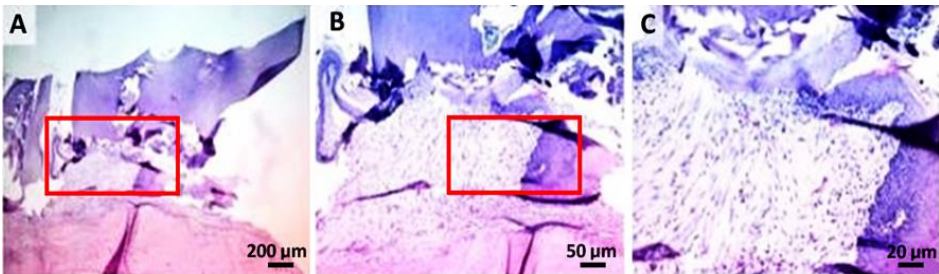
Figure 8. GO group: ( A , B ) hyperplasia and marked hyperkeratosis of the gingival epithelium, and partial replacement of the dental ligament with partially oriented fibro-vascularized connective tissue; ( C ) high resolution, 20µm, of the marked zone with red from image B.